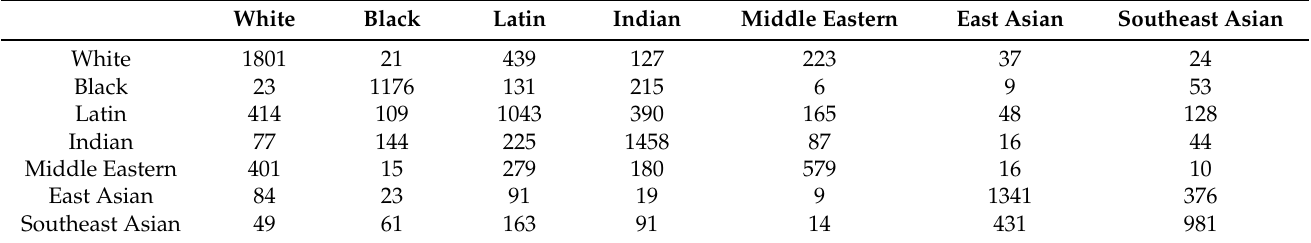
Table 16. Confusion matrix for the FairFace filtered testing with plotted landmarks.